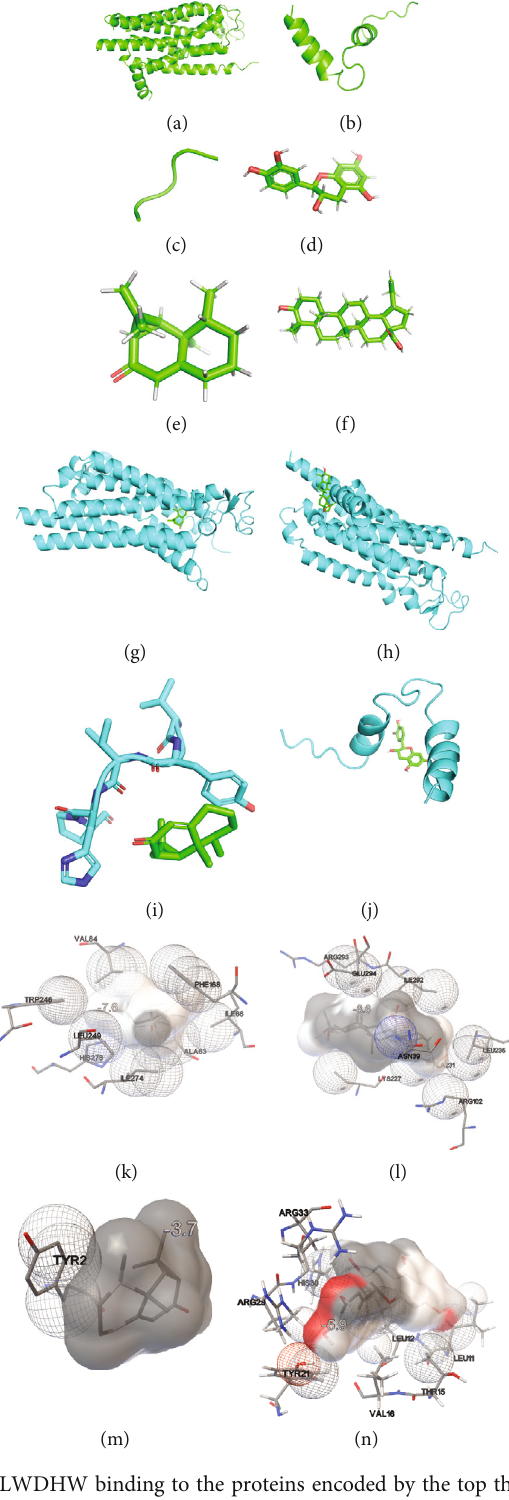
Figure 8: Molecular docking models of LWDHW binding to the proteins encoded by the top three hub target genes. (a) ADORA2A, (b) CNR1, (c) AGT, (d) catechin, (e) aristolone, (f) mairin, (g) ADORA2A and aristolone, (h) ADORA2A and mairin, (i) AGT and aristolone, (j) CNR1 and catechin, (k) ADORA2A and aristolone, (l) ADORA2A and mairin, (m) AGT and aristolone, and (n) CNR1 and catechin. Hydrogen bonded atoms in the receptor or atoms in close contact with atoms in the ligand are shown as spheres, and fragments of the secondary structure are shown as sequences of three or more residues interacting with the ligand in the